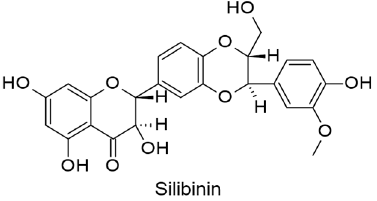
Figure 9. Chemical structure of silibinin with therapeutic action against EBV-positive nasopharyngeal carcinoma (NPC) cells.